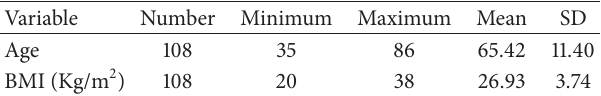
Table 1: Distribution of patients according to age and body mass